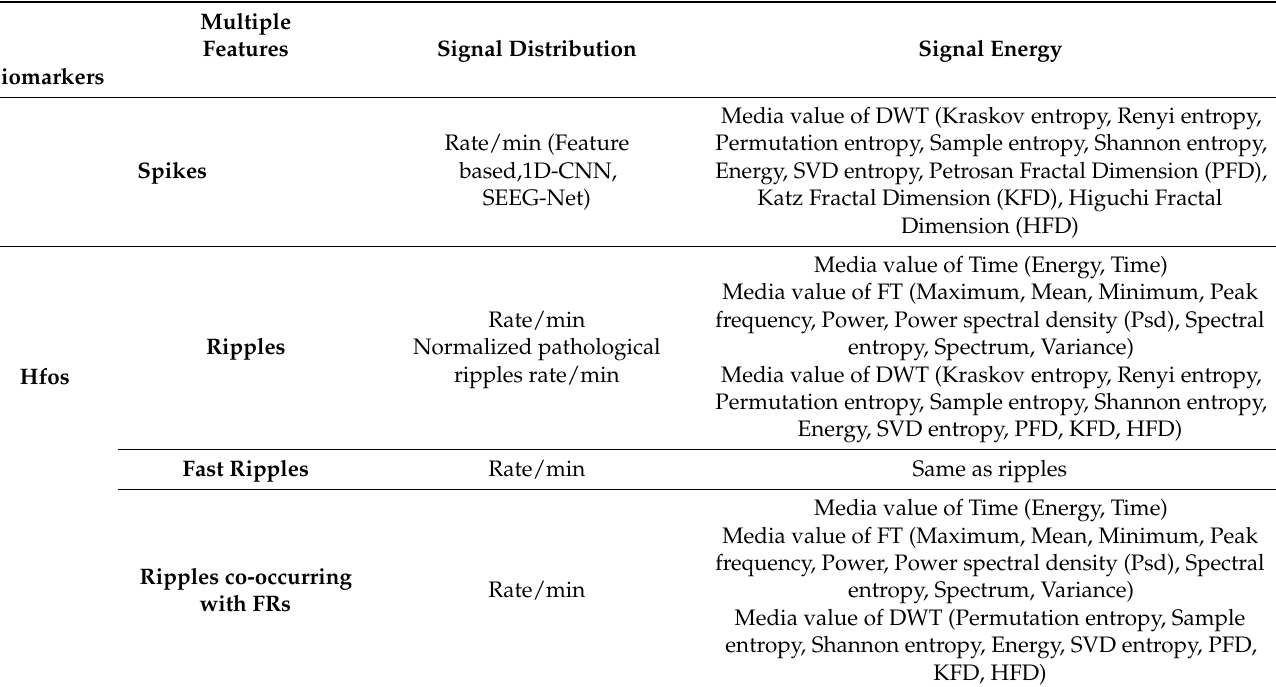
Table 1. Different features of contacts from two aspects: signal distribution and signal